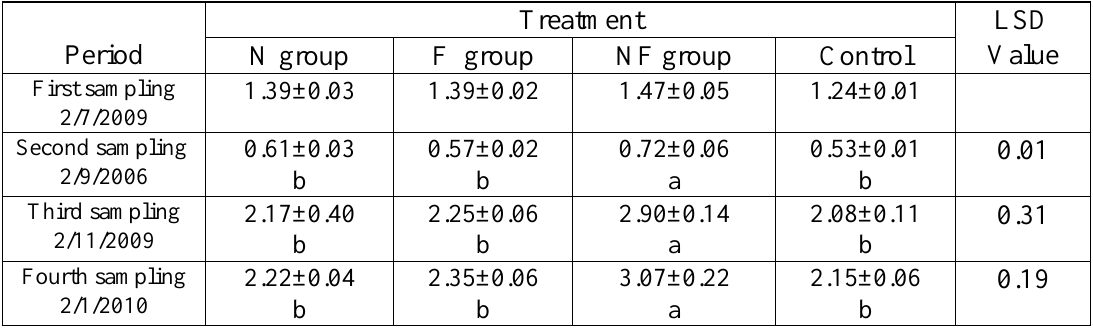
Table (2) Effect of Nigella sativa and / or Fenugreek seeds in the diet on clean wool weight (gm ) of Awassi male lambs ( means ± SE)